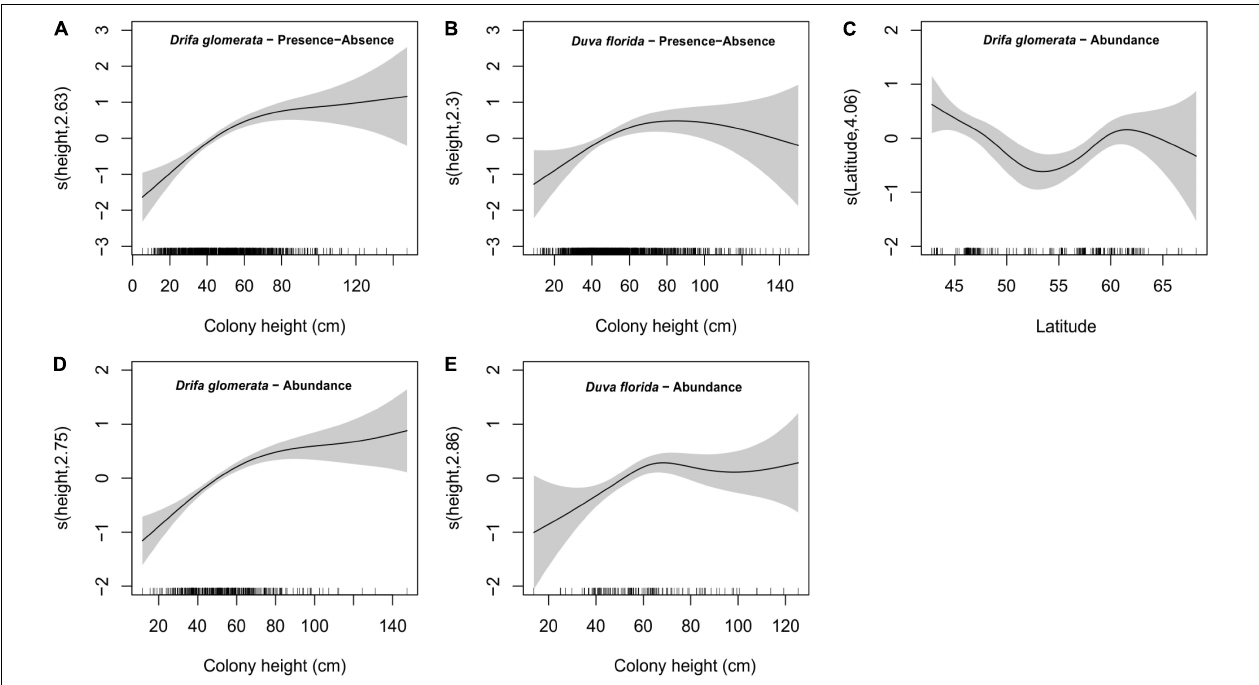
FIGURE 6 | Estimated smoothing curves for colony height obtained by the GAMMs on basket star presence-absence for Drifa glomerata (A) and Duva florida (B) , latitude (C) and colony height on abundance for Drifa glomerata (D) and colony height on abundance for Duva florida (E) . Solid lines and gray bars represent the smoothers and 95% confidence bands, respectively. Scale for the x -axis looks slightly different for presence-absence versus abundance because the number of samples available for these analyses was not the same.